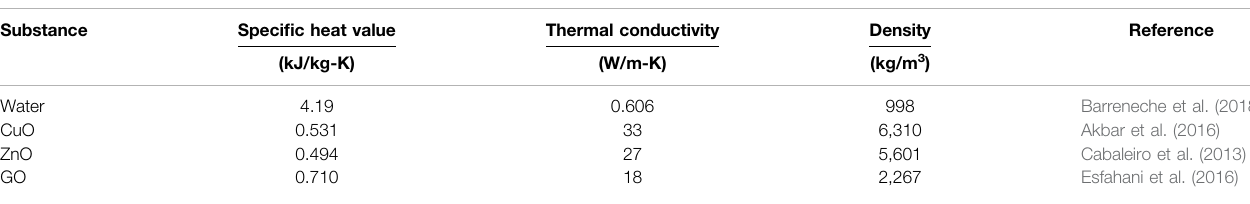
TABLE 2 | Characteristics of nanoparticles and water.